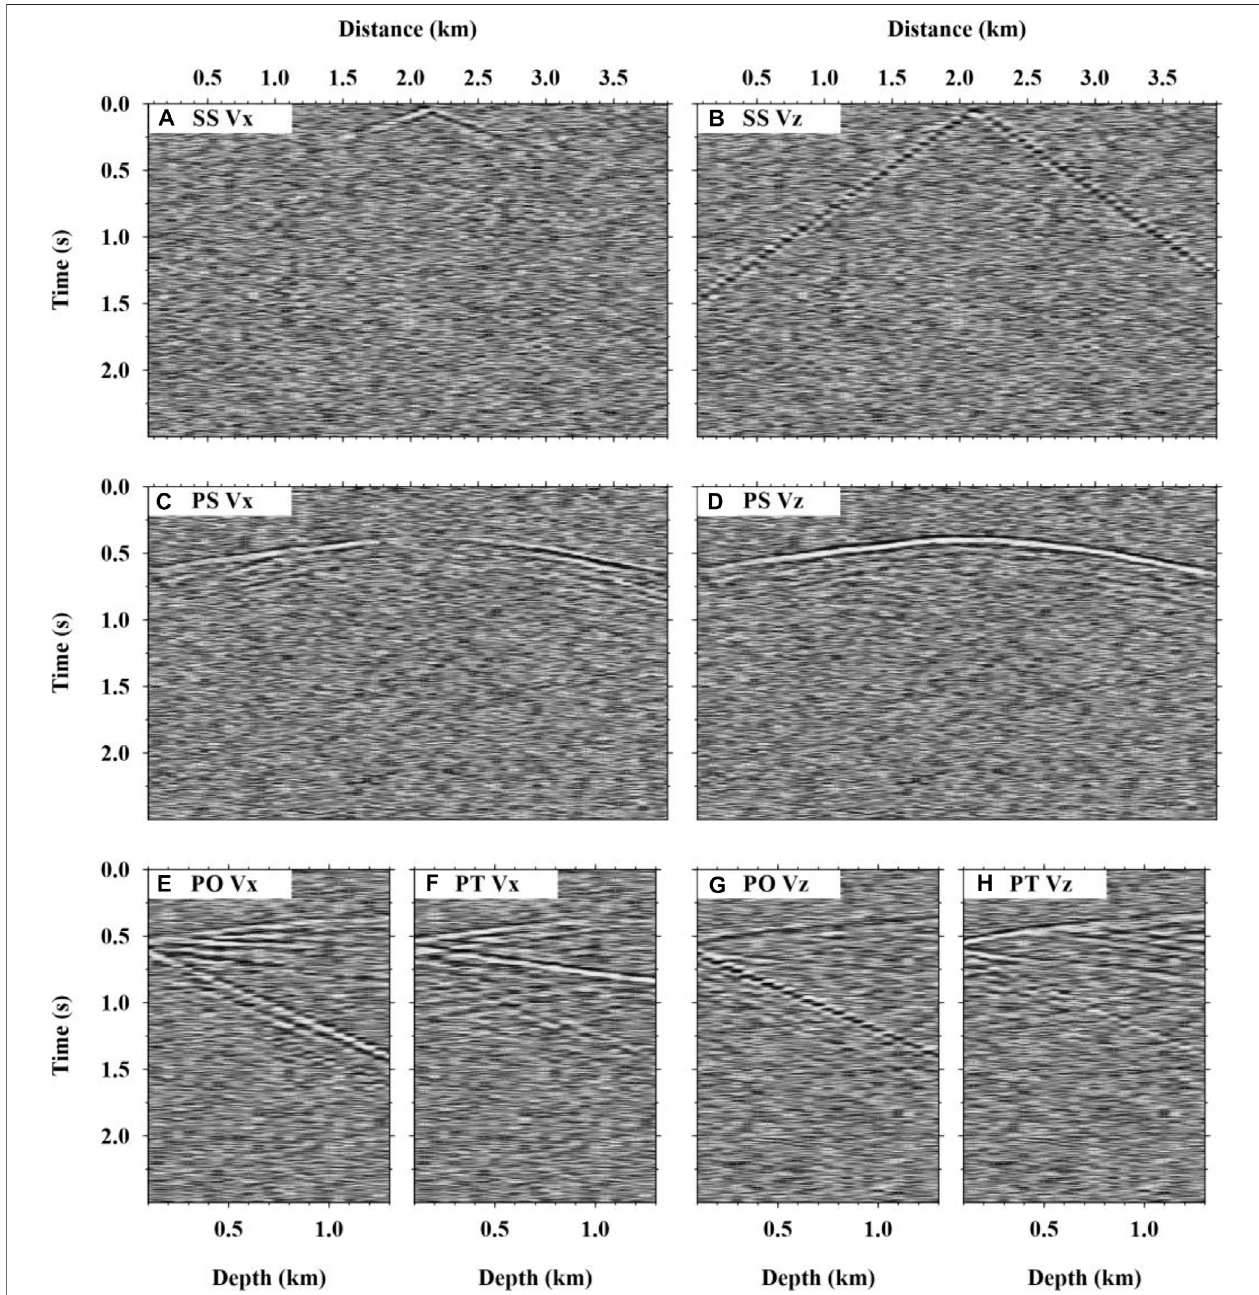
FIGURE10 | Noisy data with S/N = 2.0 synthesized byadding Gaussianto the Vxand Vz seismograms ofSS (Plots A and B ),PS (Plots C and D ), PO(Plots E and G ),andPT(Plots F and H ),asshownin Figure2 .TheseismogramsofPTwererecordedusingthearraydeployedontheverticalwellontheright-handsideofthemodel.